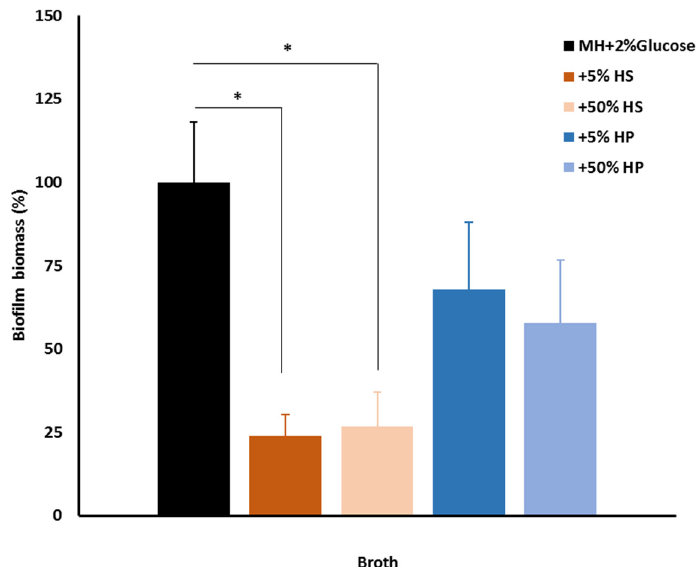
Figure 6. Impact of host factors on dual biofilm assembly. Dual biofilm biomass assessed with crystal violet assay on control (PS) and PS conditioned for 24 h with different concentrations of human serum (HS) and plasma (HP). A p < 0.05 (*) was considered statistically significant.